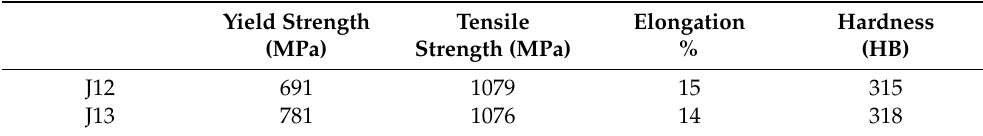
Figure 4. SEM micrographs for the two tested wheel steels, ( a ) J12 and ( b ) J13. Table 2. Mechanical properties of the wheel steels.